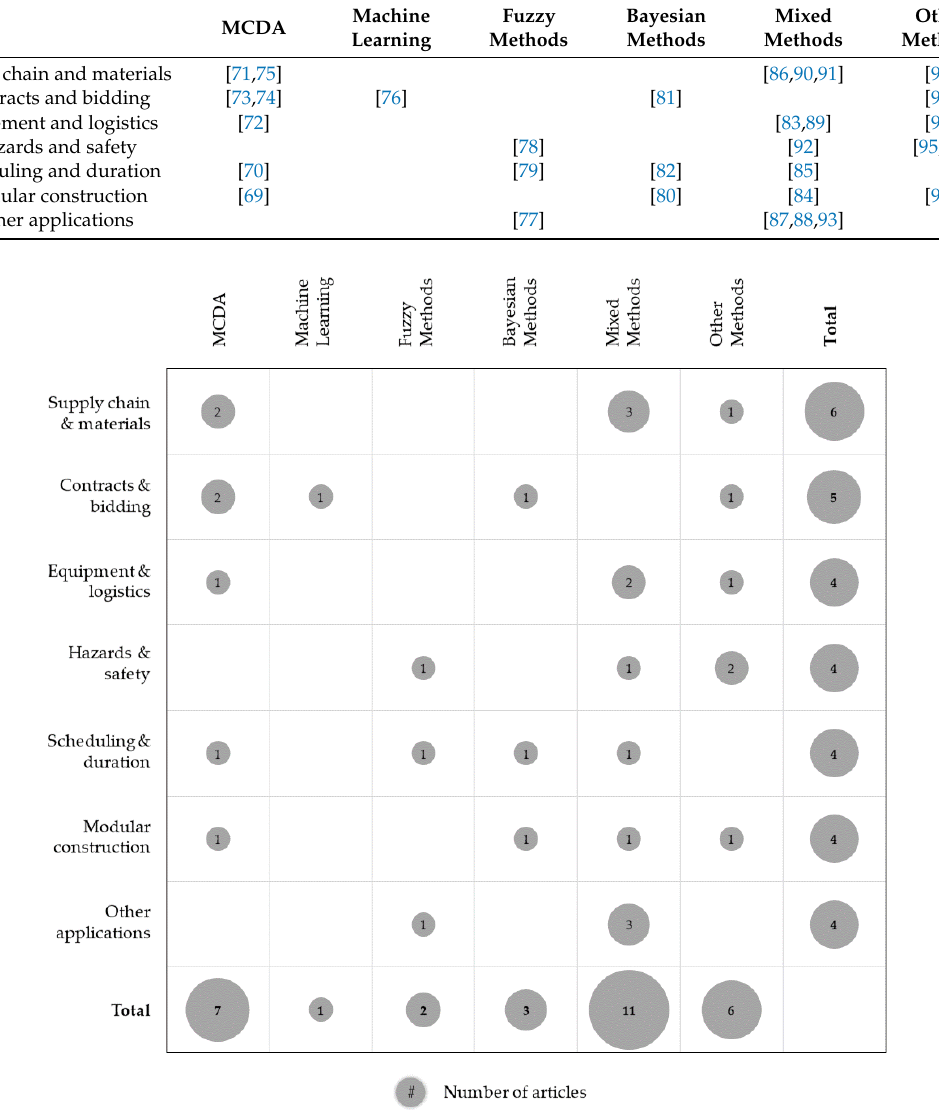
Figure 5. Construction phase. Number of articles per application area and method.